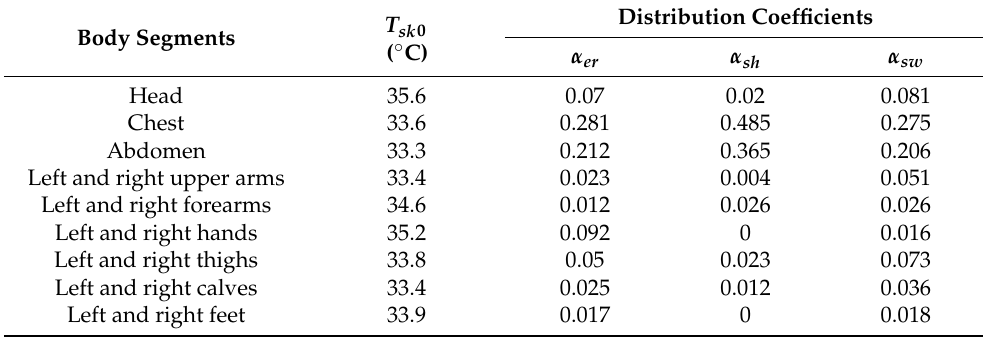
Table 2. Distribution coefficients of each body segment